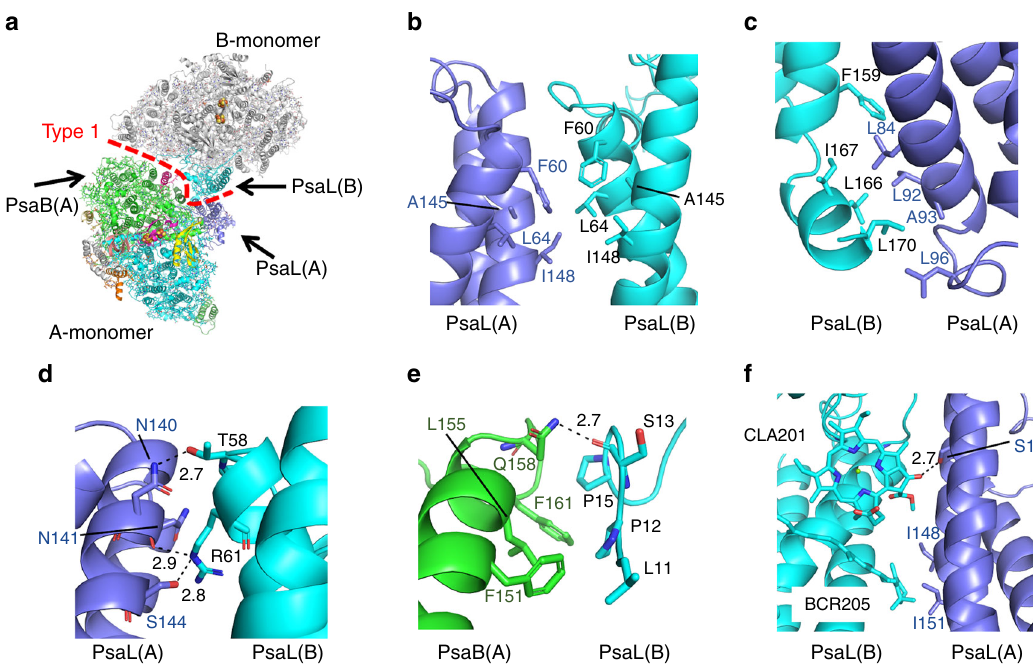
Fig. 3 Interactions at the Type 1 interface. a Structure of a dimer unit (dimer A-B) from a PSI tetramer viewed along the membrane normal from the stromal side. b – d Interactions between PsaL (A) and PsaL (B). e Interactions between PsaB (A) and PsaL (B). f Pigment interactions between PsaL (A) and PsaL (B)